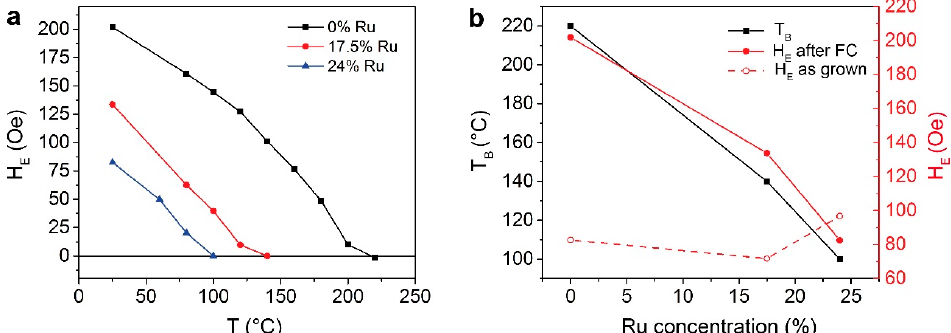
Figure 3. ( a ) Exchange bias field as a function of temperature at different Ru concentrations on bottom-pinned samples (B series); ( b ) Effect of different Ru concentrations on the blocking temperature and exchange bias field for bottom-pinned samples.